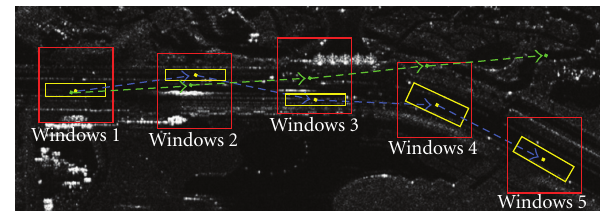
Figure 8: Road center-points extraction methods comparison 1.